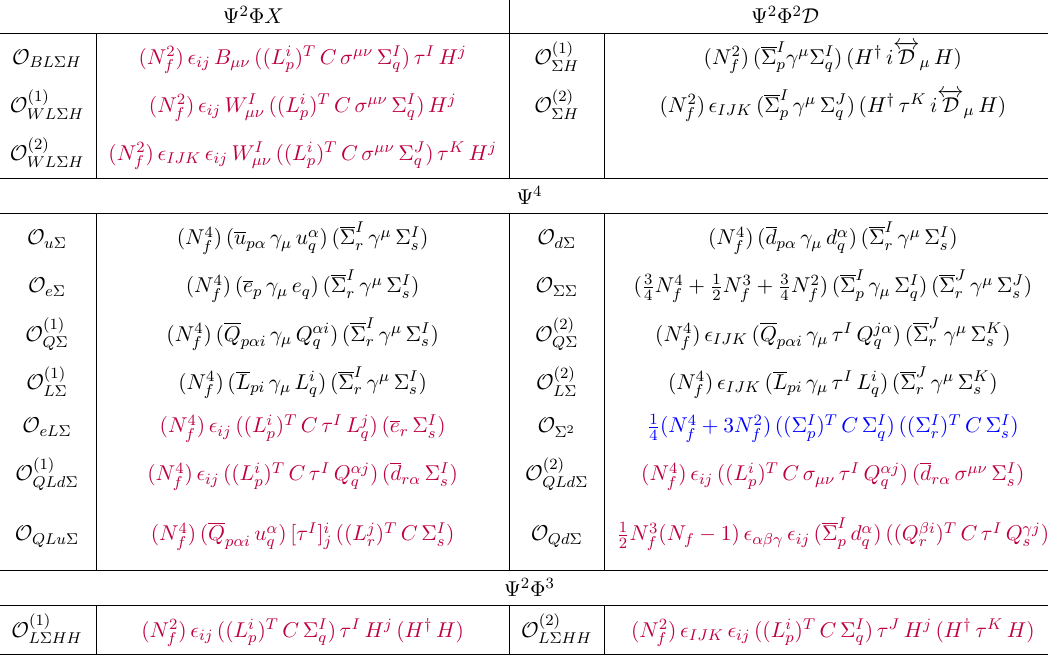
Table 9 . SM extended by Left-Handed Triplet Fermion ( Σ ): additional operators of dimension 6. Here i, j and α, β, γ are the SU(2) and SU(3) indices respectively. τ I are the SU(2) generators. I, J, K = 1 , 2 , 3 . p, q, r, s = 1 , 2 , · · · , N f are the flavour indices. Operators in red violate lepton and baryon